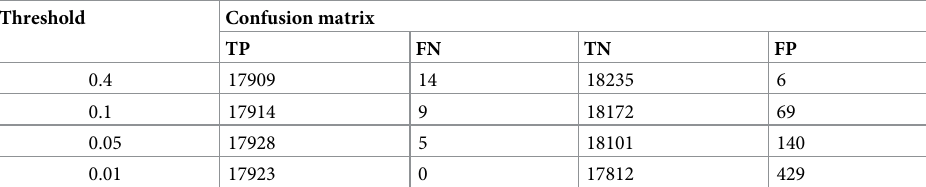
Table 5. Confusion matrix among different thresholds.